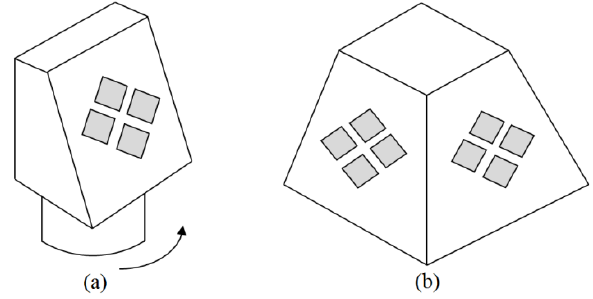
Figure 7. Scanning alternatives. ( a ) Rotational basis. ( b ) Pyramidal